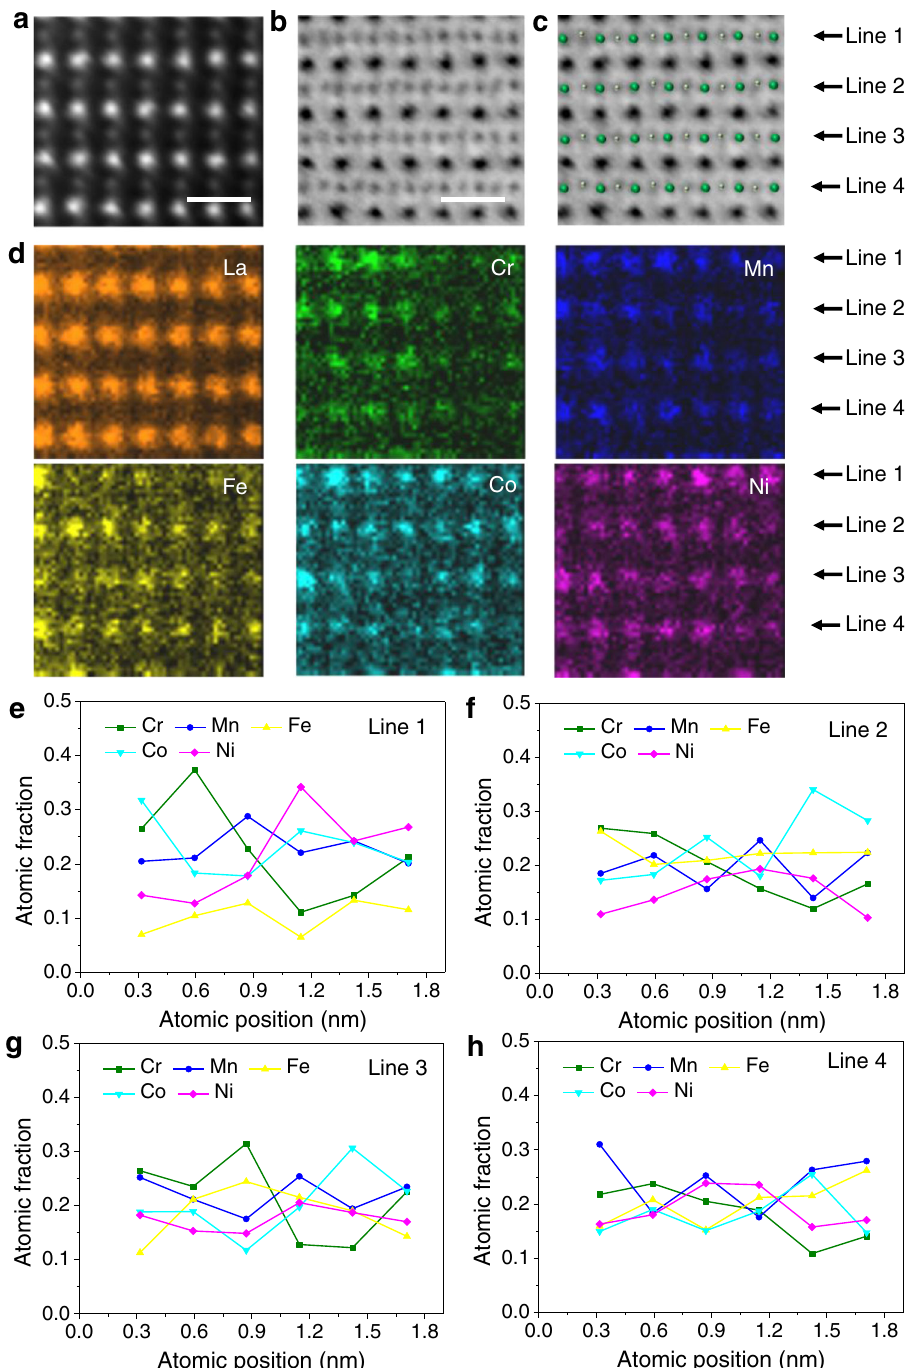
Fig. 2 Atomic structure and compositional fl uctuation of La(5TM0.2)O3. a HAADF-STEM, b ABF, and ( c ) marked ABF images of La(5TM 0.2 )O 3 taken from [110] zone axis. Scale bar, 0.5 nm. The green and silver dots marked in c denotes the B-site atoms and oxygen atom, respectively. d Atomic EDS mapping showing the disordered elemental distribution in the B-site of the ABO 3 structure. e – h Line pro fi les of the atomic fraction calculated from the relative intensity, representing the distribution of individual B-site elements in a (001) plane projected along the [110] zone